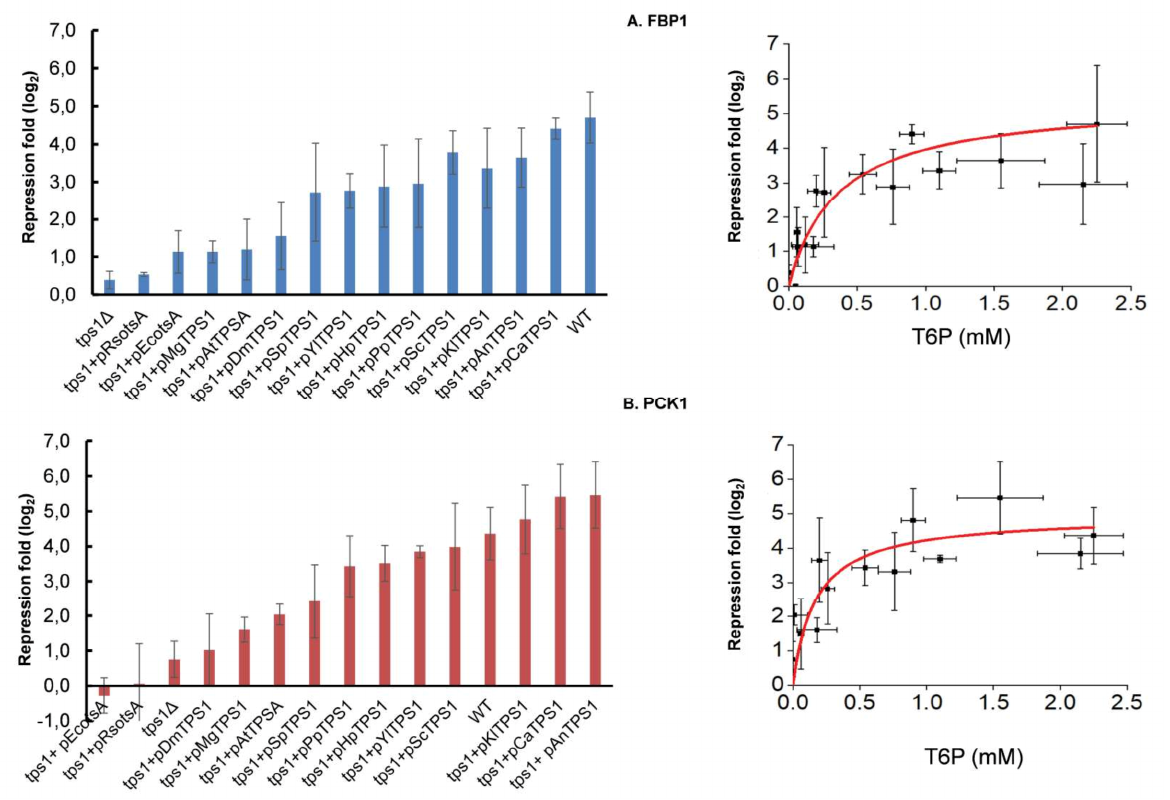
FIGURE 8: Expression level of FBP1 (A) and PCK1 (B) in S. cerevisiae tps1 mutant complemented with TPS1 from different organisms. The Sctps1 strains transformed with YCpL33 plasmid and with TPS1 homologues were cultivated on YN containing ethanol 2% until 5 units OD 600 . At this time, glucose (10 g/L final) was added and samples (15 OD units) were taken before and 1 h after glucose addition. The tran- script levels of FBP1 and PCK1 was quantified by RT-qPCR using TAF10 and KRE11 as reference genes for normalization. Results shown are the mean of